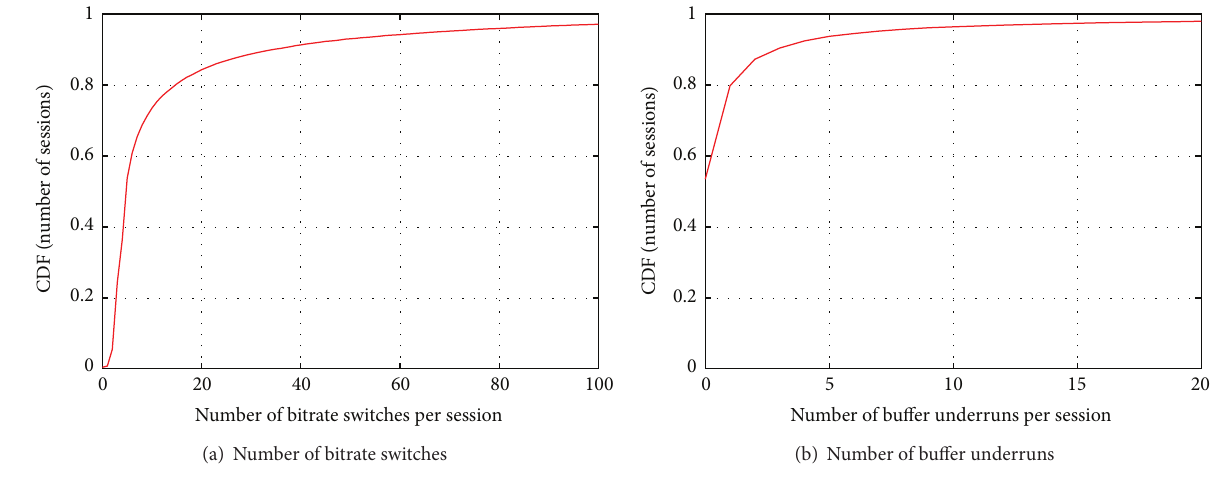
Figure 3: Client access patterns.